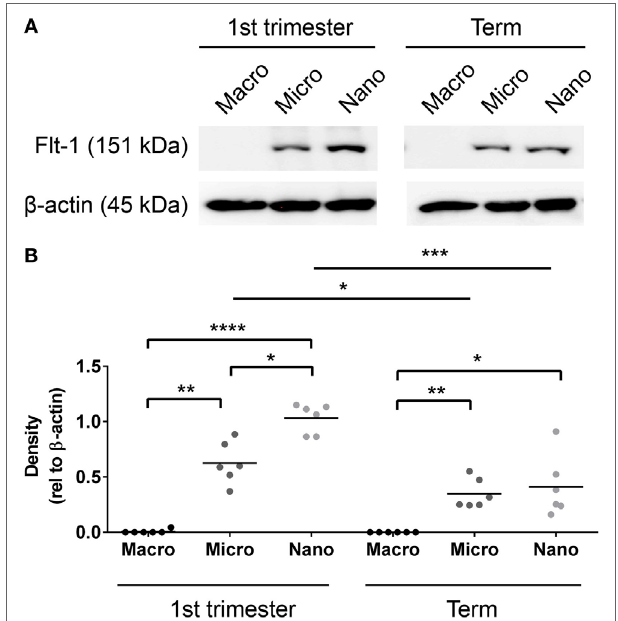
FigUre 4 | Levels of Flt-1 carried by micro- and nano-vesicles extruded from preeclamptic (PE) and normotensive placentae. The levels of Flt-1 present in micro- (M) and nano- (N) vesicles derived from normotensive ( n = 10), mild PE ( n = 5) and severe PE ( n = 9) placentae were investigated by western blotting (a) . Densitometric analysis was performed relative to β -actin with the mean values as indicated [ (B) , * p < 0.05, unpaired t -test].